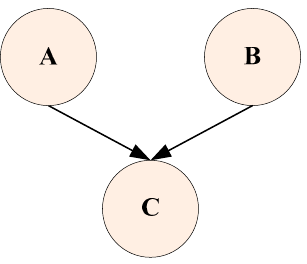
Figure 1. A simple flow diagram of the BN. Table 1. A sample of the CPT related to Figure 1.